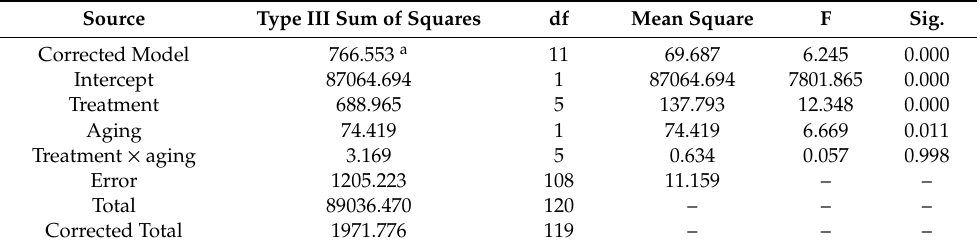
Table 9. Tests of between-subject e ff ects to show the influence of treatment techniques, aging condition, and the impact of tretment-aging; dependent variable is shear bond strength values. Source Type III Sum of Squares df